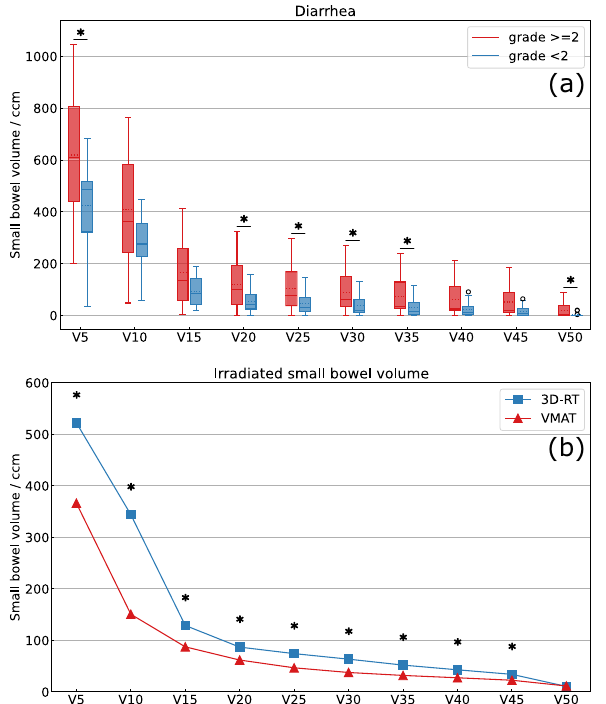
Figure 2. ( a ) Dependence of diarrhea on irradiated small bowel volume of all evaluated patients (n = 34) treated with 3D-conformal radiotherapy. Dose levels V5-50 are displayed as boxplots; box = interquartile range, solid horizontal line = median, dotted horizontal line = mean, whiskers 1.5 × IQR, dots = outliers. Statistical analysis was performed using Wilcoxon rank-sum test. A p-value < 0.05 was considered statistically significant. * = significant difference p < 0.05, ccm = cubic centimeter. ( b ) Reduction of irradiated small bowel volume receiving doses from 5 to 50 Gy after volumetric modulated arc therapy (VMAT) re-planning compared to the 3D-conformal radiotherapy treatment plans. Mean dose levels V5–V50 are displayed. Statistical analysis was performed using Wilcoxon signed rank test. A p-value < 0.05 was considered statistically significant. * = significant difference p < 0.01, ccm = cubic centimeter, 3D-RT = 3D-conformal radiotherapy, VMAT = volumetric modulated arc